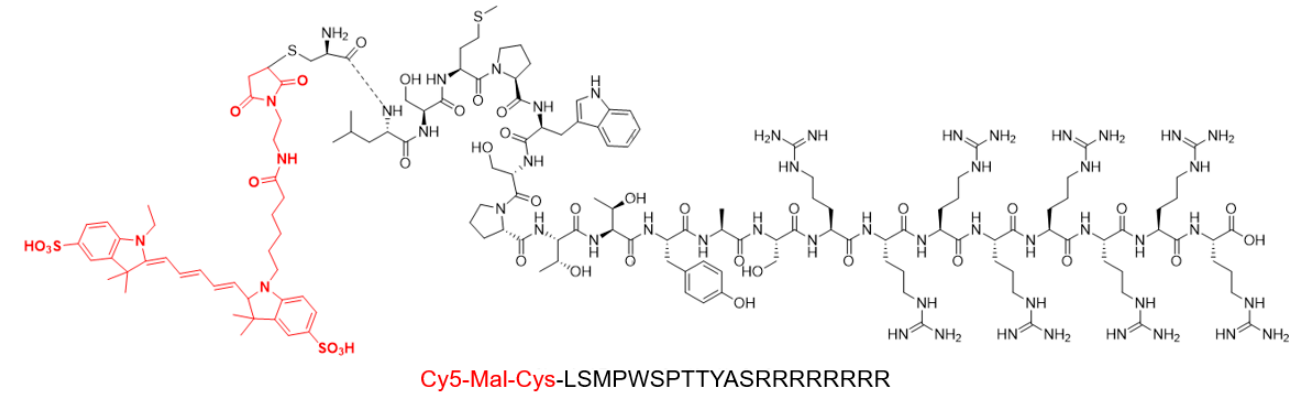
Figure 3. Chemical structure of P12-Cy5. The screened P12 peptide was conjugated to an arginine- penetrating peptide (RRRRRRRR) at the C-terminus and a Cy5 fluorescent group (marked in red) at the N-terminus.